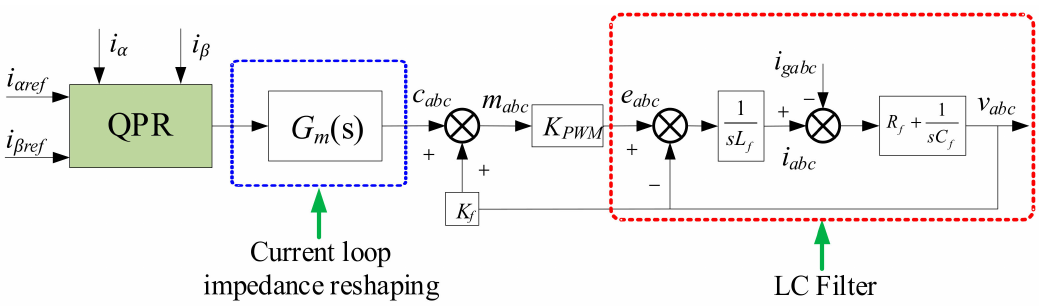
Figure 9. Proposed current loop impedance reshaping control